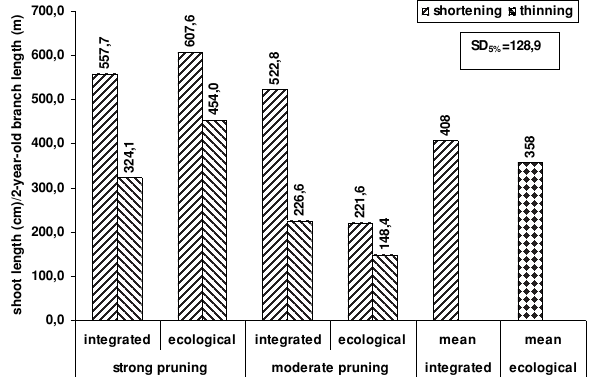
Figure 4. Effect of the intensity as well as of the method of pruning on ‘Idared’ apple trees grafted on M 26 rootstock affecting total shoot growth as well as specific shoot length in integrated and ecological growing systems. (Debrecen-Pallag, 2008)